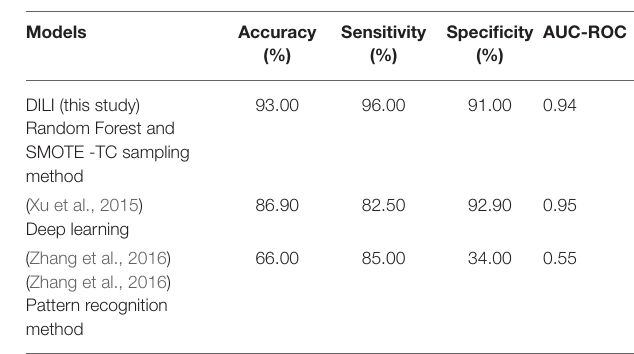
based on MACCS and Morgan fingerprints are provided as Supplementary Figure 7 .